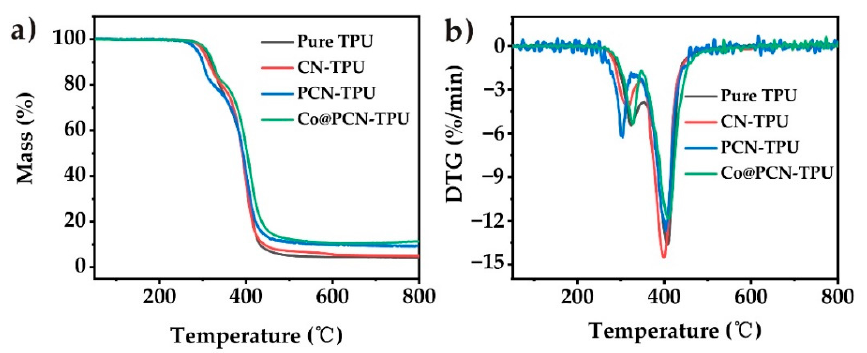
Figure 6. ( a ) TG and ( b ) DTG curves of TPU and its composites in nitrogen atmosphere.